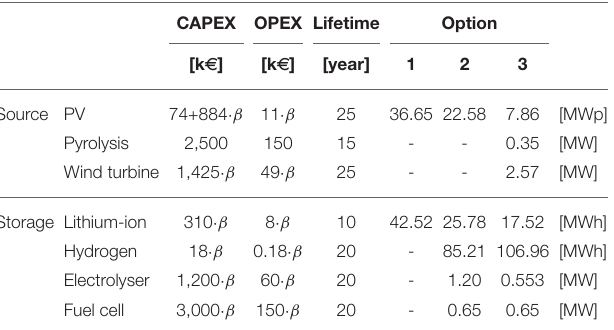
Costs are given by a linear function of the amount of nominal power or capacity installed, denoted β , with units shown in the last column. For example, the CAPEX for the lithium-